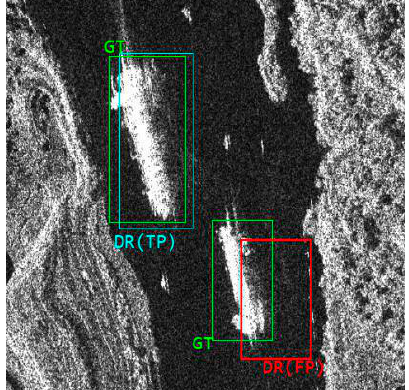
Figure 8. Intersection over Union (IoU) Judgment Criteria.